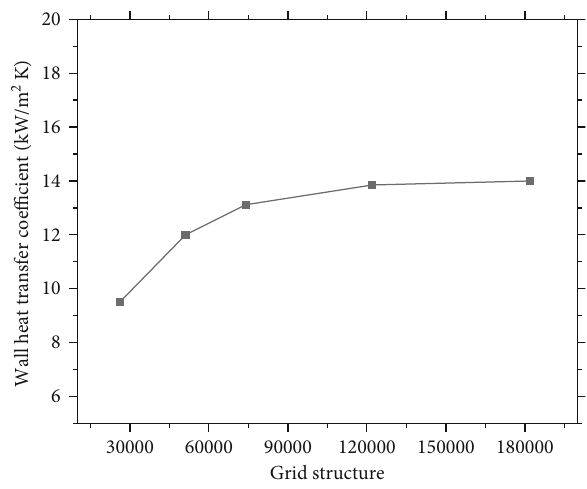
Figure 3: Grid independence